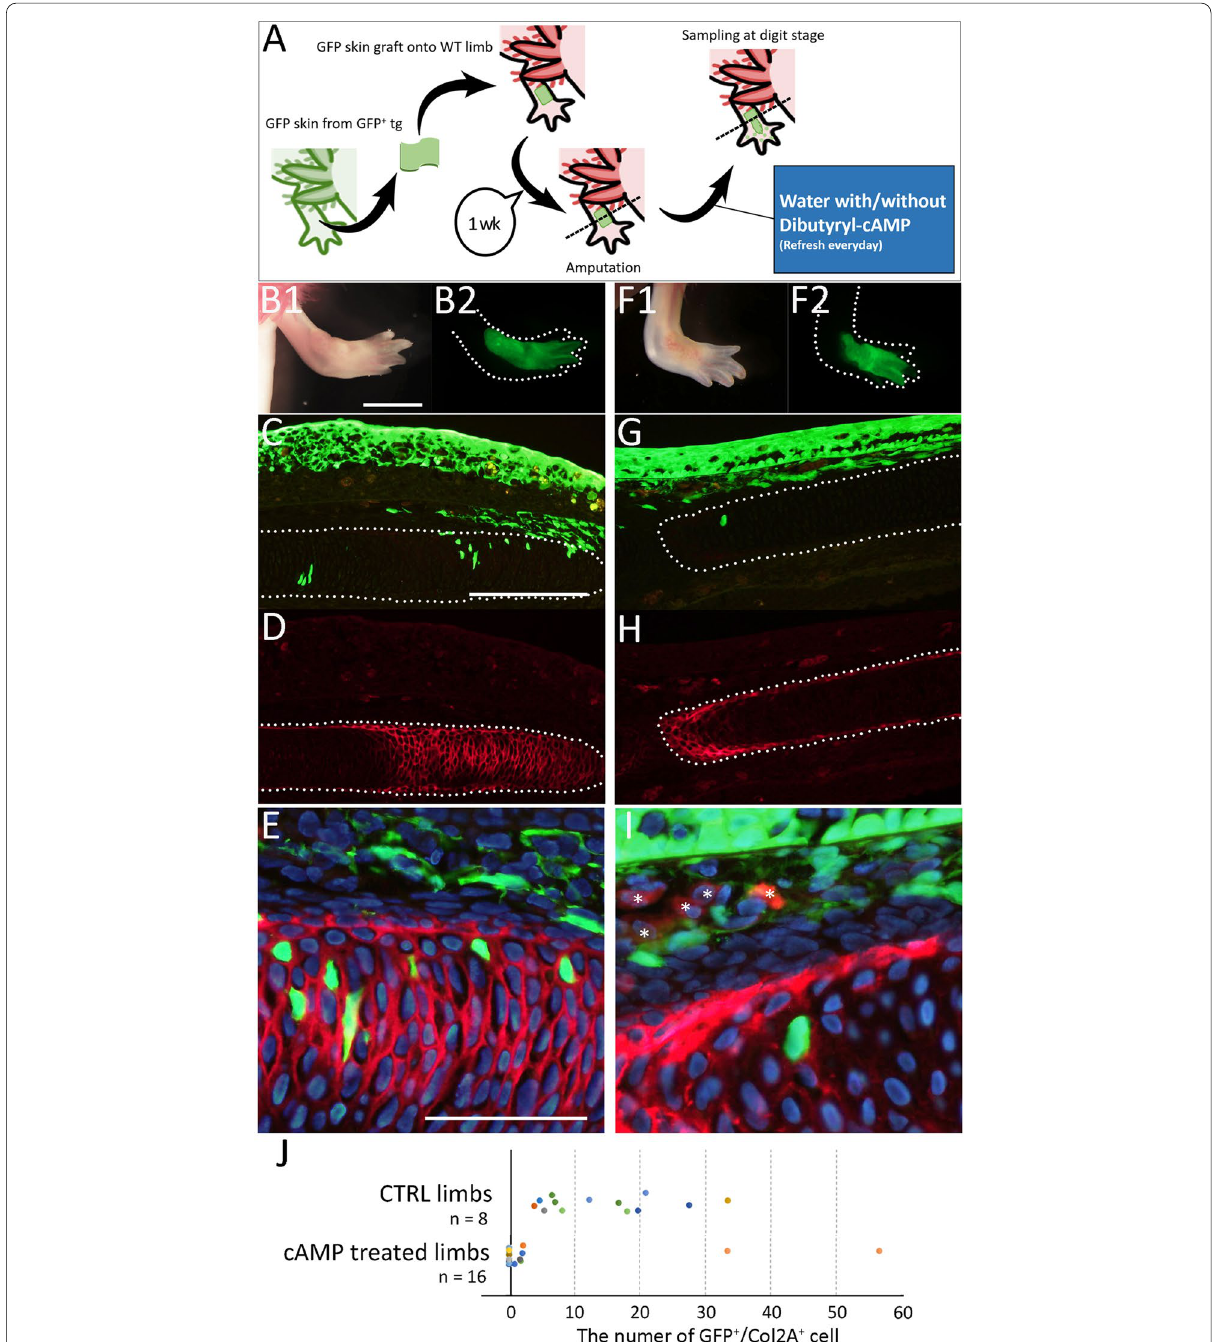
Fig. 7 Distribution of GFP cells in the dibutyryl-cAMP treated animal. A the schematic diagram of the experiment. The GFP-skin grafted limb of + the control animal ( B – E ) and the dibutyryl-cAMP treated animal ( F – I ). B , F The GFP-grafted limb just before sampling. C – E , G – I The distribution of the GFP + cells and Col2a expression were visualized by immunofluorescence. E , I the merged and higher magnified image of C and D . The asterisks in I indicate the red blood cells. The dotted lines indicate the border of the cartilage. J The plot of the number of GFP + Col2a + cells. The scale bars in B1, C, and E are 3 mm, 300 μm, and 100 μm,